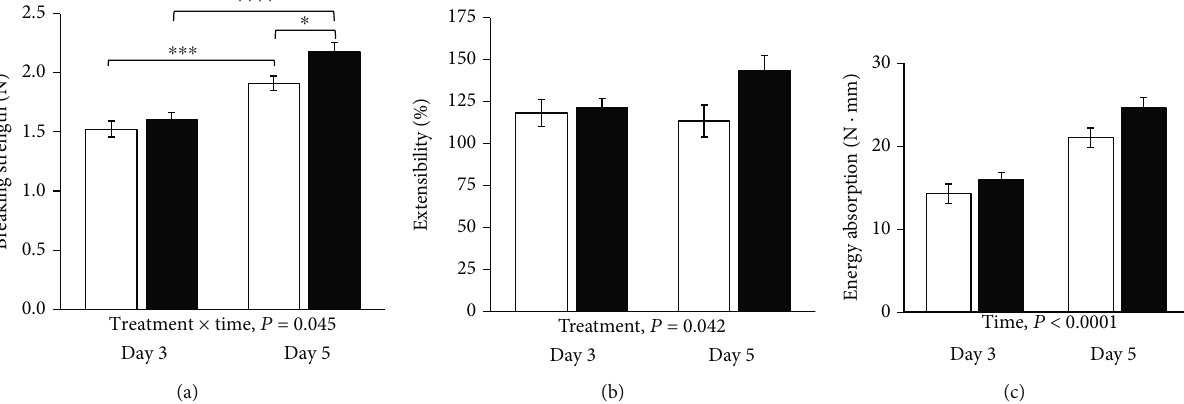
Figure 2: Anastomotic breaking strength (a), extensibility (b), and energy absorption (c). Open bars: vehicle; fi lled bars: ZP1849. ∗ P < 0 : 05 , ∗∗∗ P < 0 : 001 , and ∗∗∗∗ P < 0 : 0001 . Mean ± SEM .